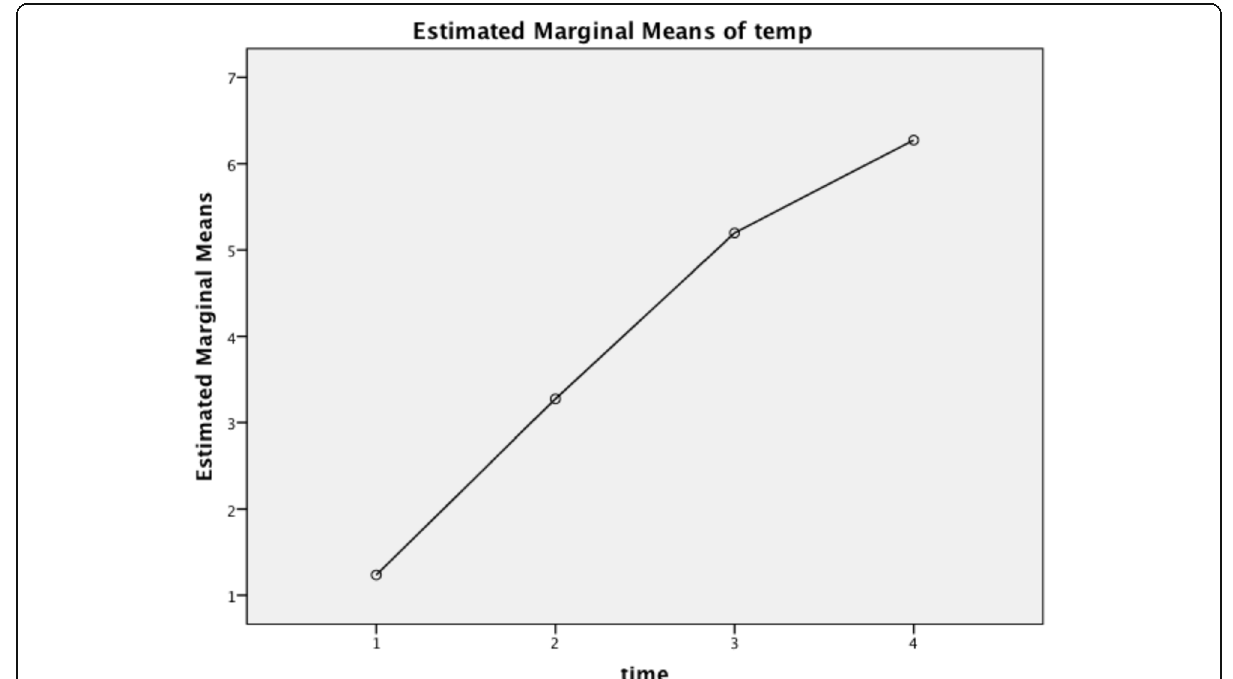
Fig. 8 Student Temperature Scores across Four Iterations of the